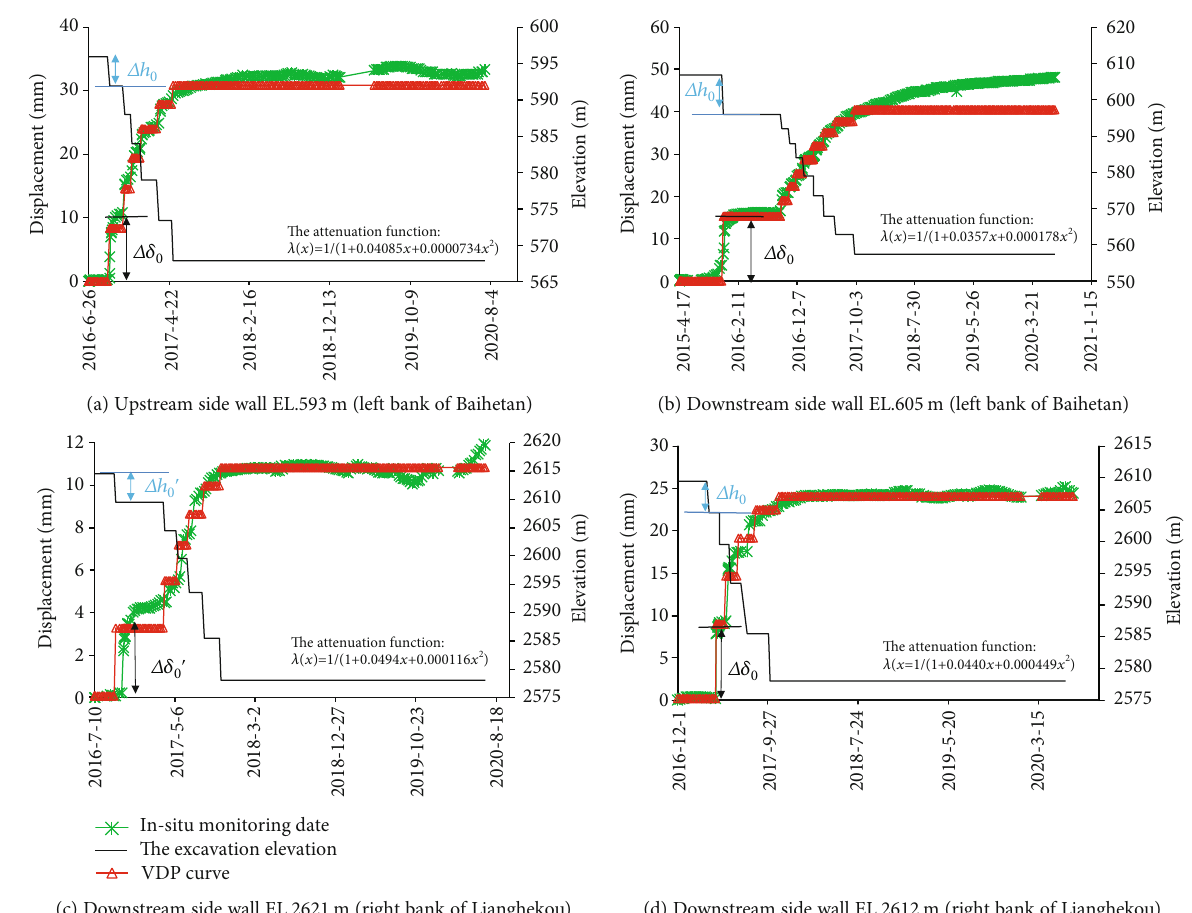
Figure 10: Veri fi cation of VDP curve calculation results and in situ monitoring